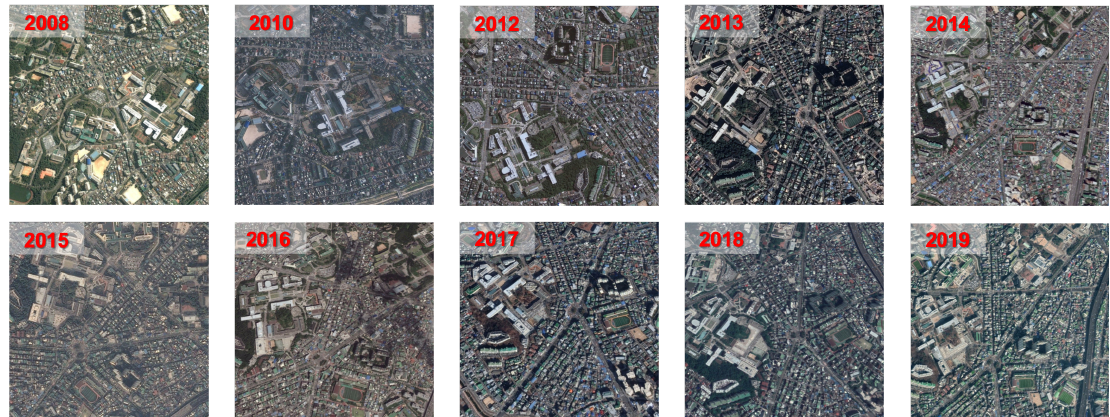
Figure 1. Variance in the aerial image data. We captured images that were obtained at different times, viewpoints and by different sensors. These images represent the same place but are visually different, which causes degradation in performance.